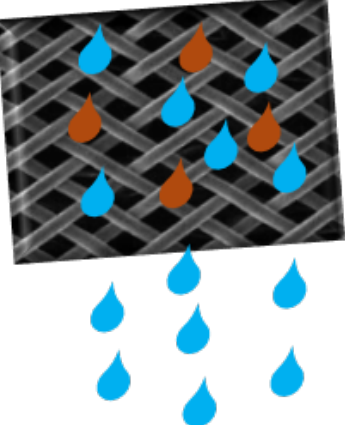
Figure 7. Superhydrophilic mesh for oil–water